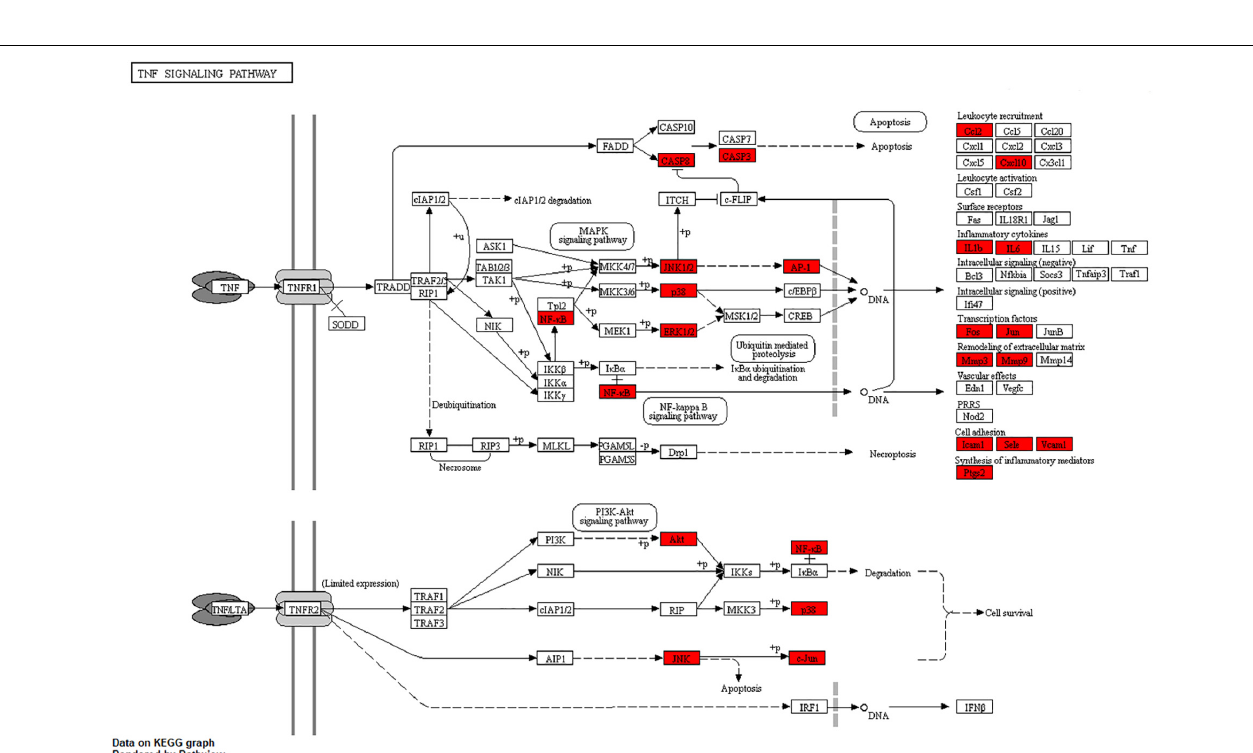
FIGURE 7 | The TNF signaling